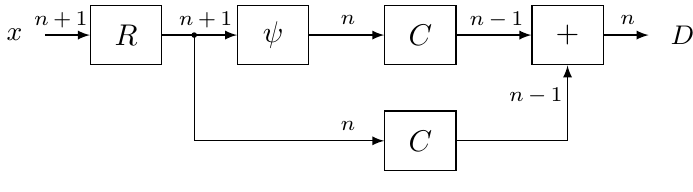
Figure 5: The sequence of gadgets in C n